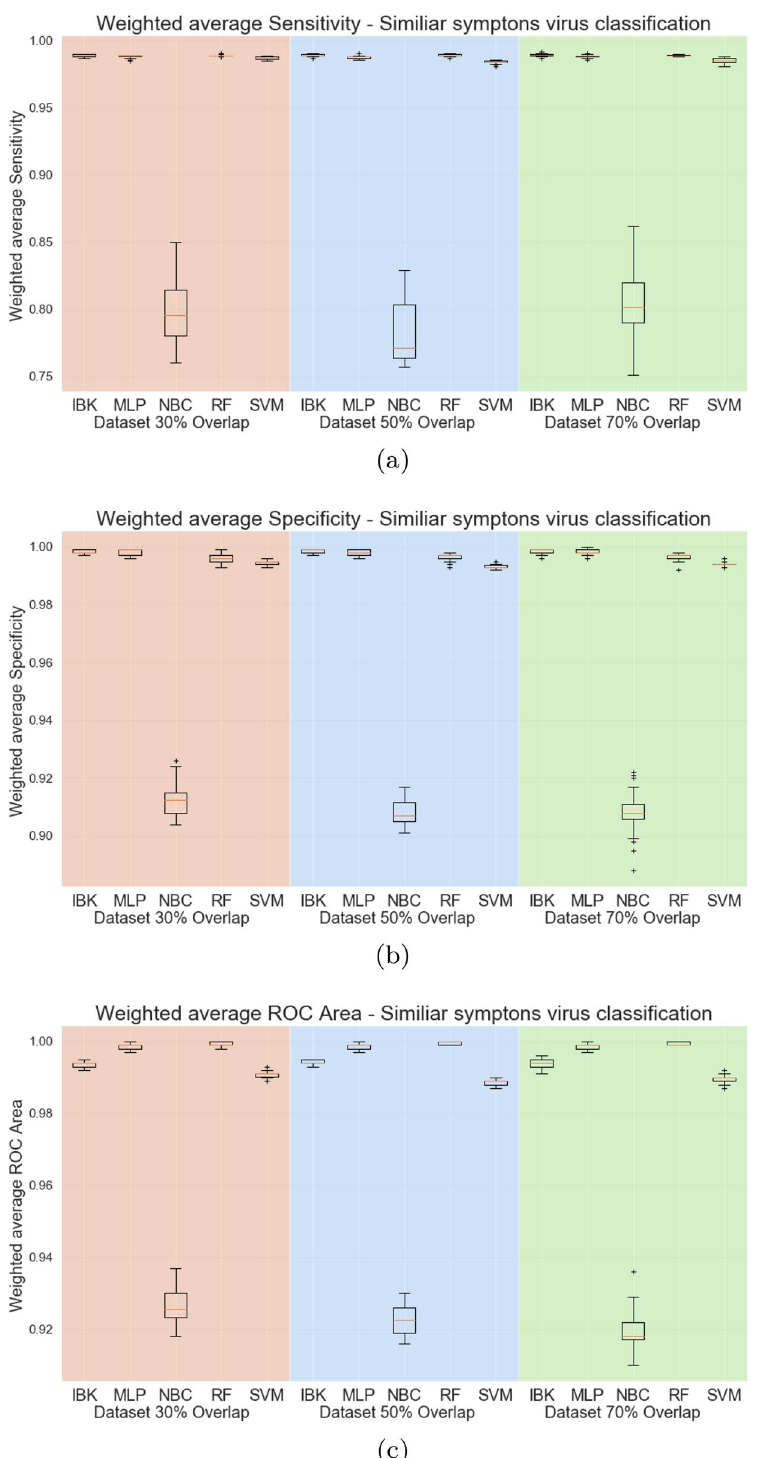
Figure 14. Weighted average sensitivity ( a ), specificity ( b ), and ROC area for similar symptoms viruses test